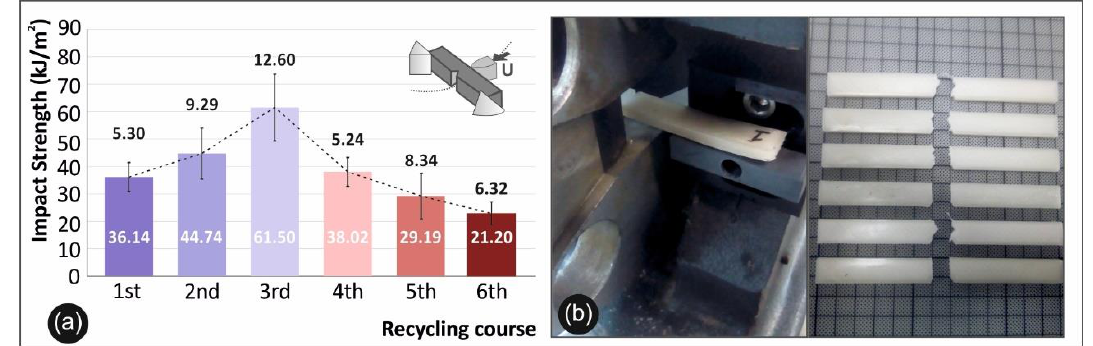
Figure 6. Impact tests: ( a ) comparison of the impact strength average values along with the calculated deviation from each recycle course studied and ( b ) device experimental setup and specimens after the test.